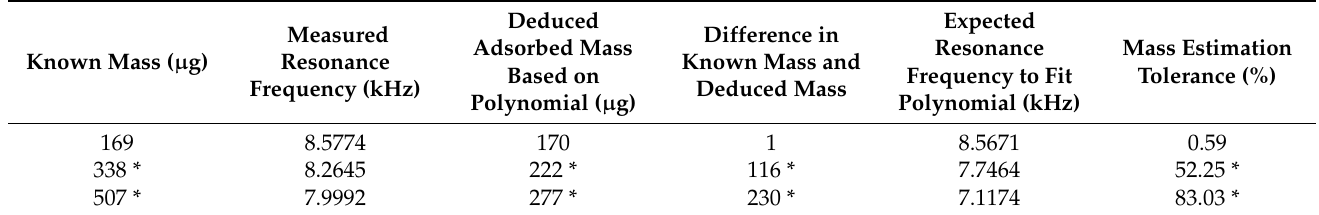
Table 3. Resonance frequency response to added mass test masses with expected resonance frequency from the parameterized response. The (*) shows values due to masses outside the calibration range.